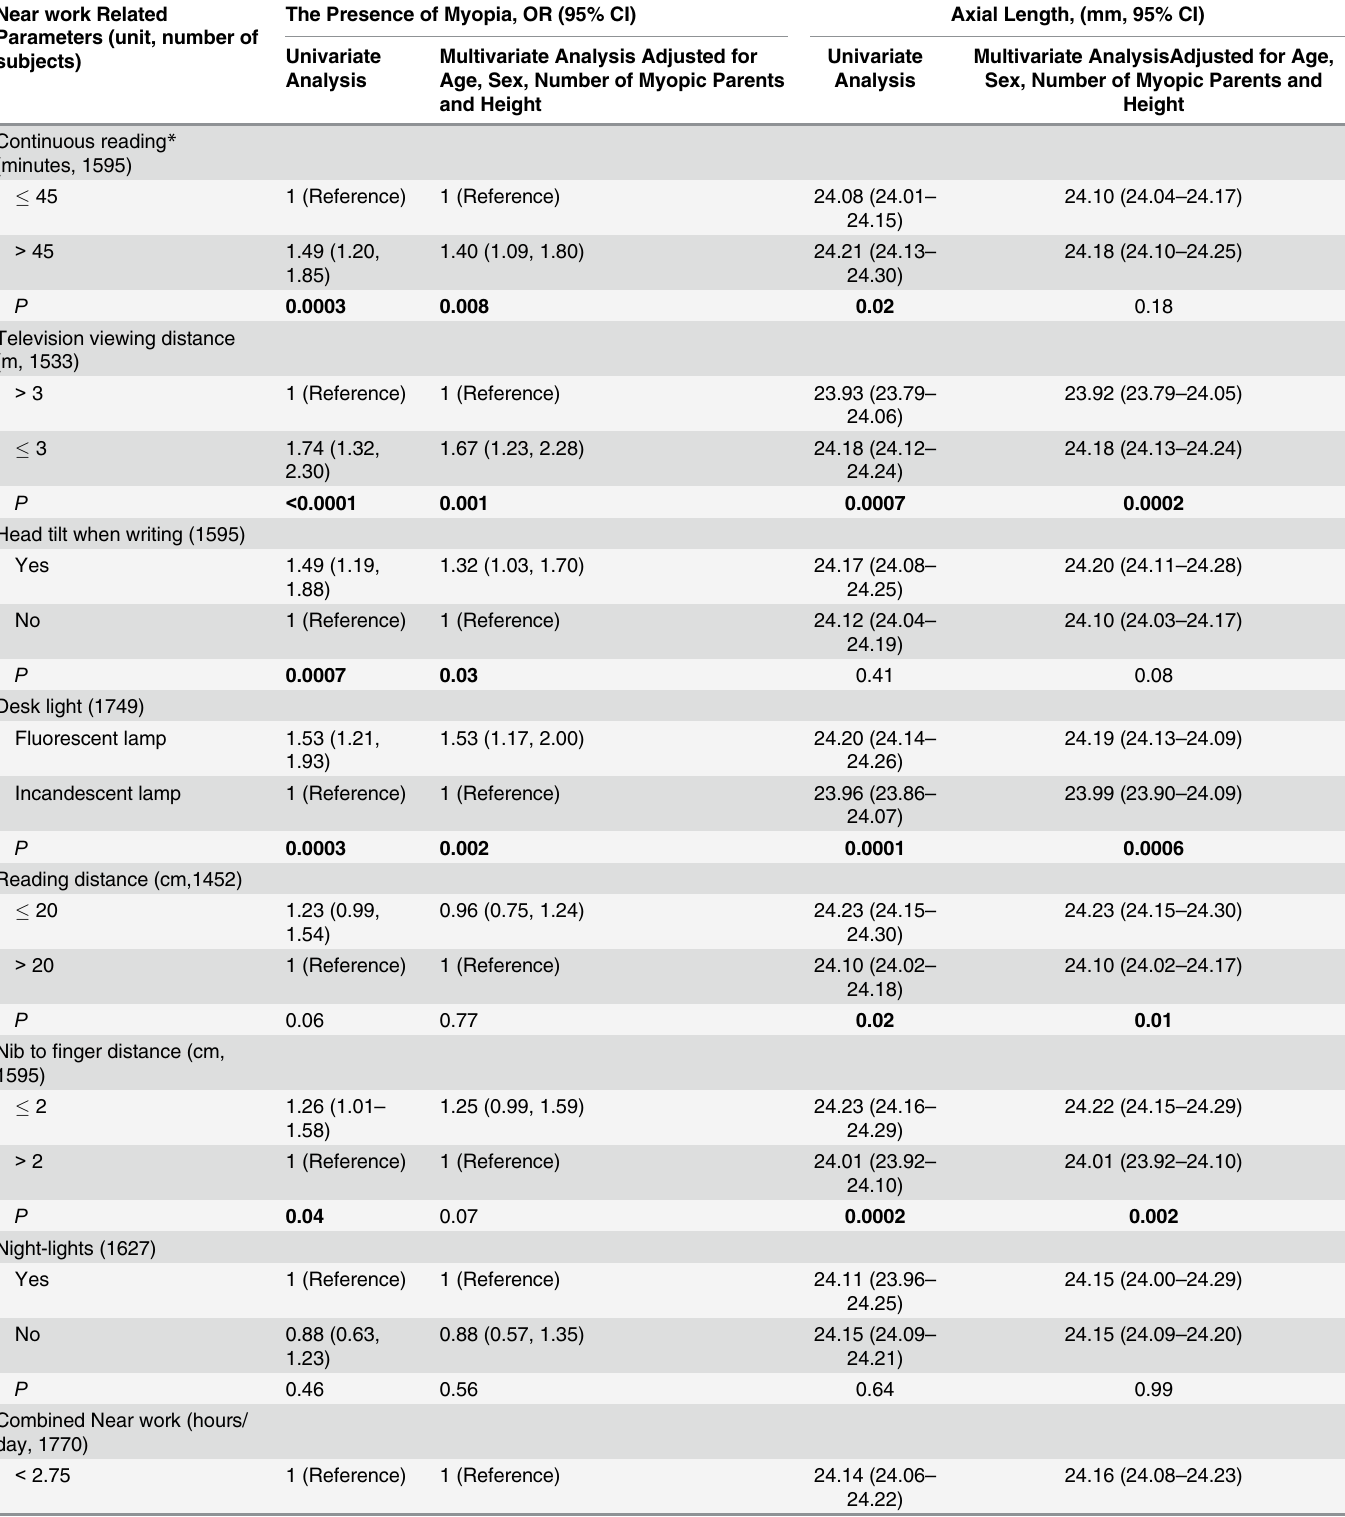
Table 4. Associations of Near work Related Parameters with the Presence of Myopia and Axial Length. Near work Related Parameters (unit, number of subjects)